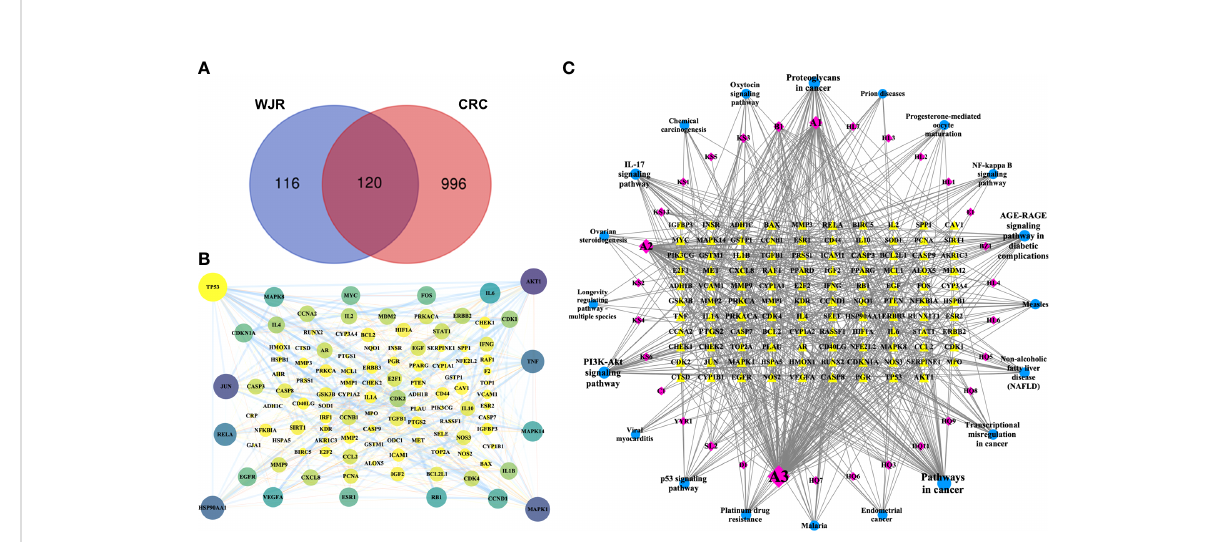
FIGURE 2 Potential anti-tumor mechanisms of WJR for CRC. (A) Venn diagram of WJR-related targets intersected with 1116 CRC-related targets. (B) PPI network of candidate WJR targets for CRC treatment. (C) PPI network of WJR-active ingredients, CRC-related targets, and signaling pathways. Yellow, CRC-related targets; purple, WJR-active ingredients; blue, signaling pathways. WJR, Wenzi Jiedu Recipe; CRC, colorectal